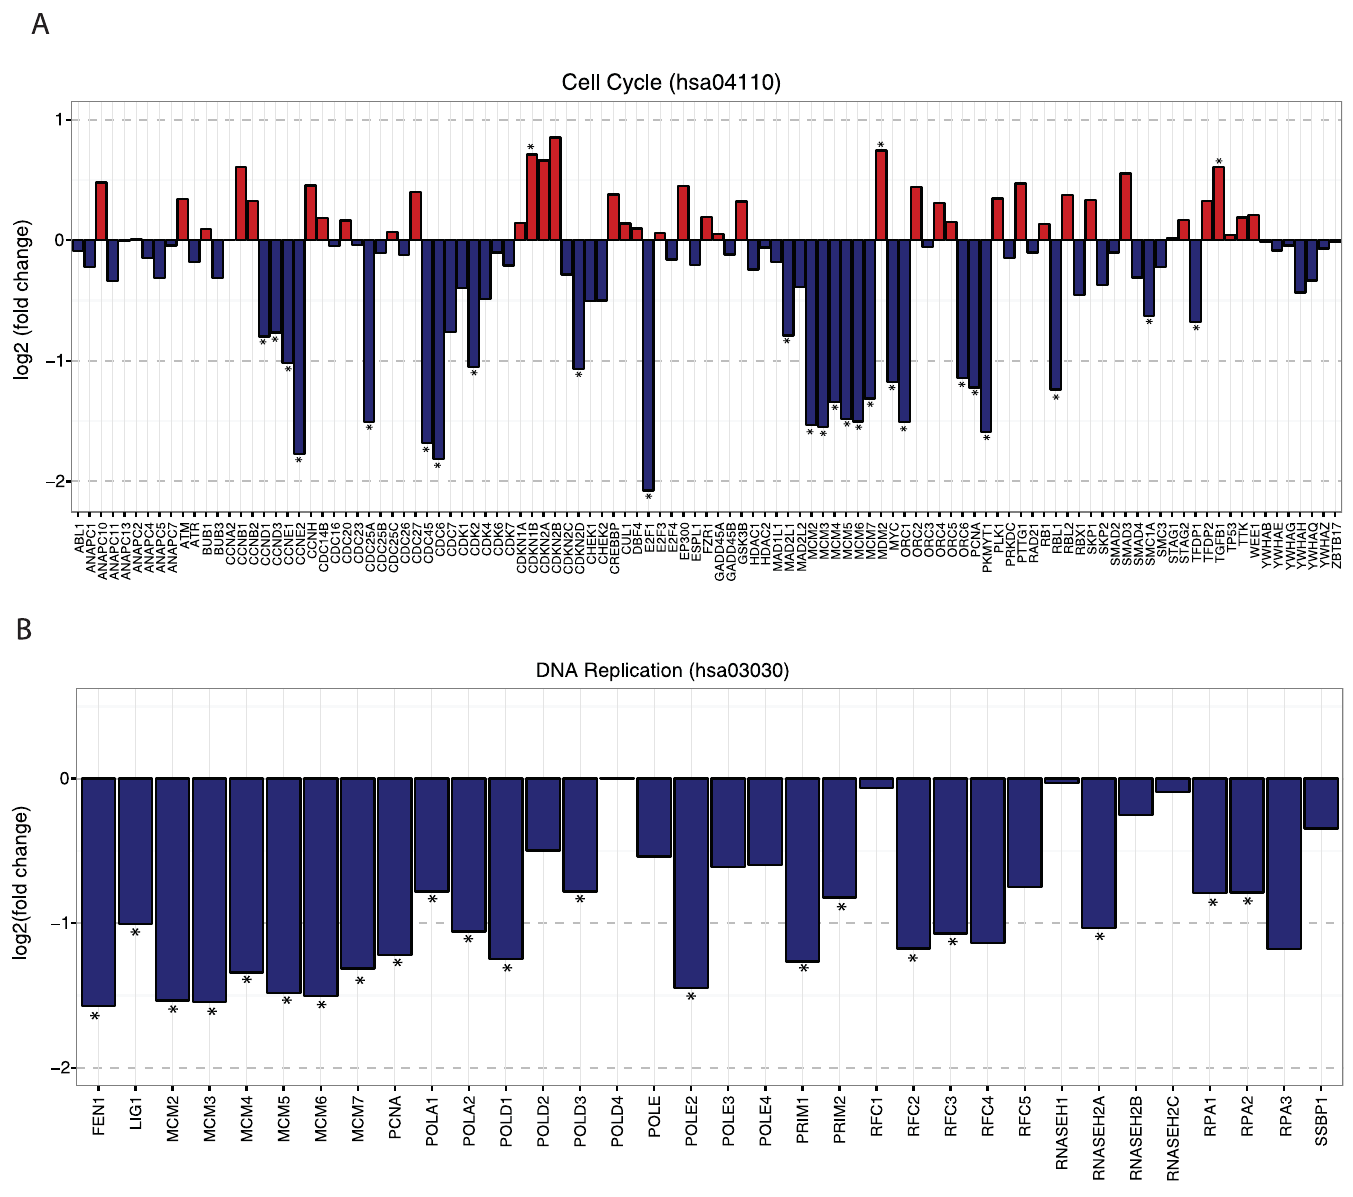
Fig 4. Differential expression of genes in the cell cycle pathway. Differential expressionof genes in the cell cycle pathway (hsa04110, upper panel) and DNA replication(hsa03030, lower panel)for COL6-RDdominant negativevs. null (lower panel). Log 2 fold change is plotted for each gene in the pathway (positivevalues reflect increasedexpressionin the dominant negativemutants). Genes with significantdifferential expression (FDR-adjusted p-value was < 0.05) are marked with an * .